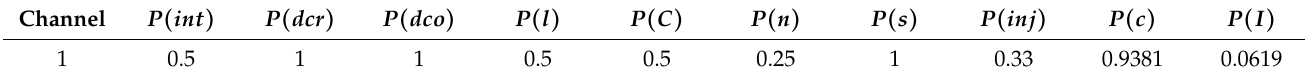
Table 3. Input and output values for a single-channel